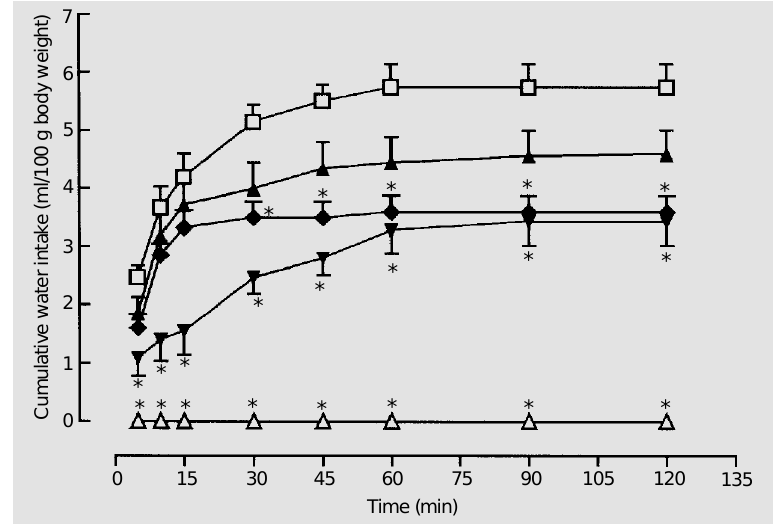
Figure 1. Cumulative water intake (ml/100 g body weight) in animals submitted to a previous intragastric salt load receiving third ventricle injections of GR 113808 at different doses or isotonic saline solution (controls). The following groups are represented: salt load + saline (squares; N = 9); salt load + GR 40 nmol/rat (filled triangles; N = 13); salt load + GR 80 nmol/rat (filled lozenges; N = 9); salt load + GR 160 nmol/rat (inverted filled triangles; N = 12). An additional group receiving intragastric isotonic saline solution under the same conditions as used to promote salt load and receiving isotonic saline injections in the third ventricle (normal salt + saline, open triangles; N = 13) is also shown. Data are reported as means ± SEM. *P<0.05 compared to salt load + saline (two-way analysis of variance followed by the Student-Newman- Keuls test).